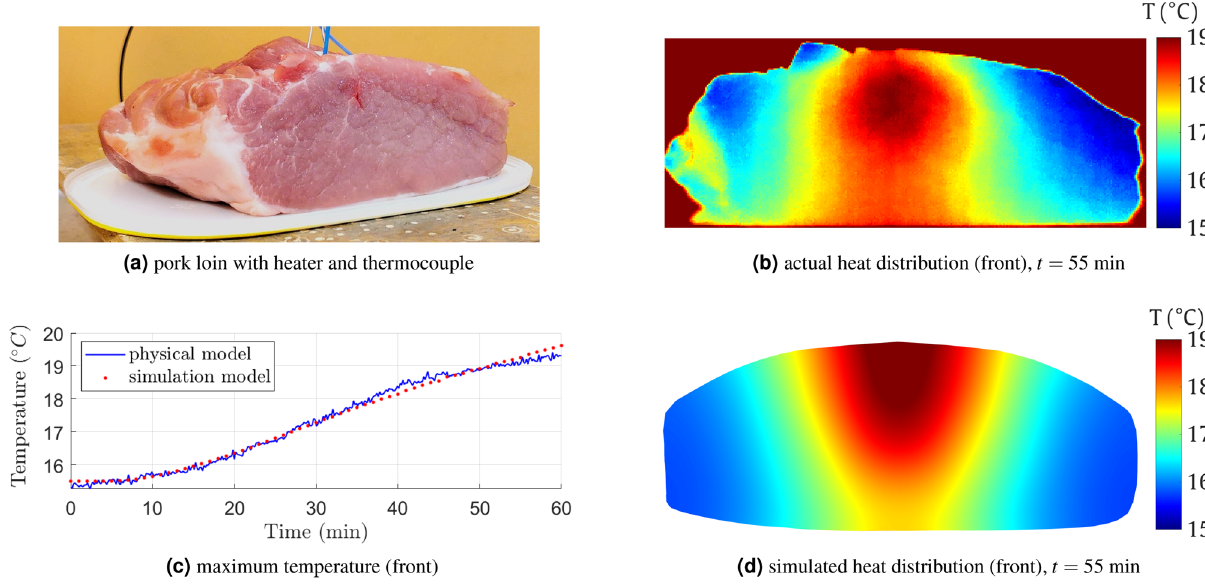
Figure 6. Model evaluation (experiment #1) using a pork loin ( a ), the obtained heat map ( b ), and heat map from the numerical model ( d ) on the front of the loin. The chart ( c ) shows the actual an simulated maximum temperature (front of the loin).